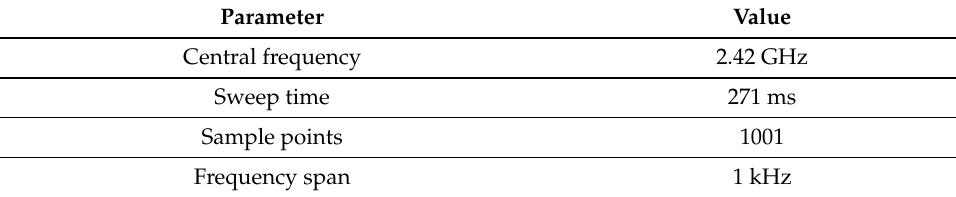
Table 3. Spectrum analyzer